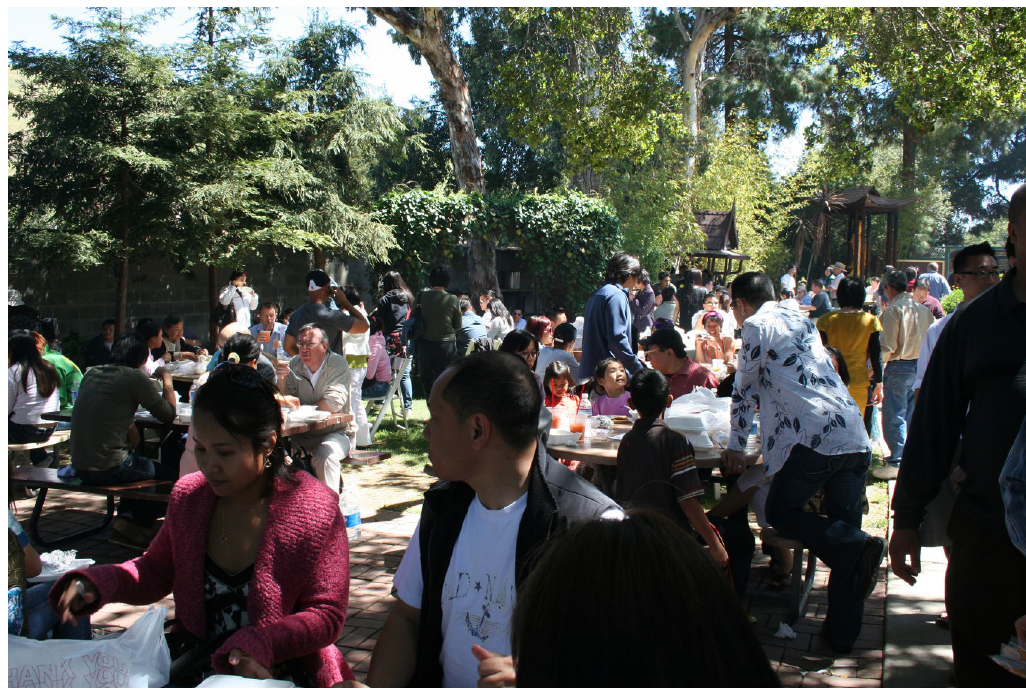
Figure 1: Eating outdoors (photograph by the author,